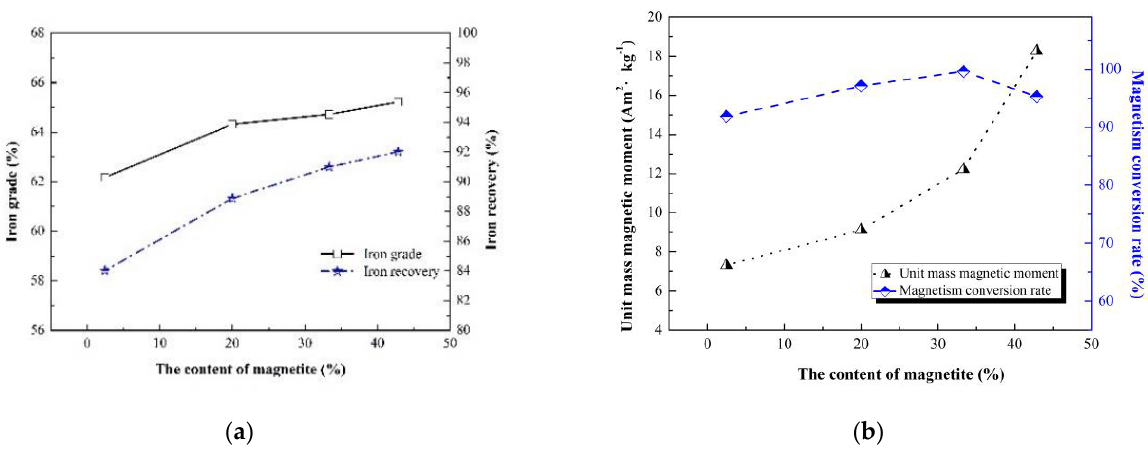
Figure 14. The separation index ( a ) and magnetism conversion ( b ) of sample A to D under optimum roasting conditions.